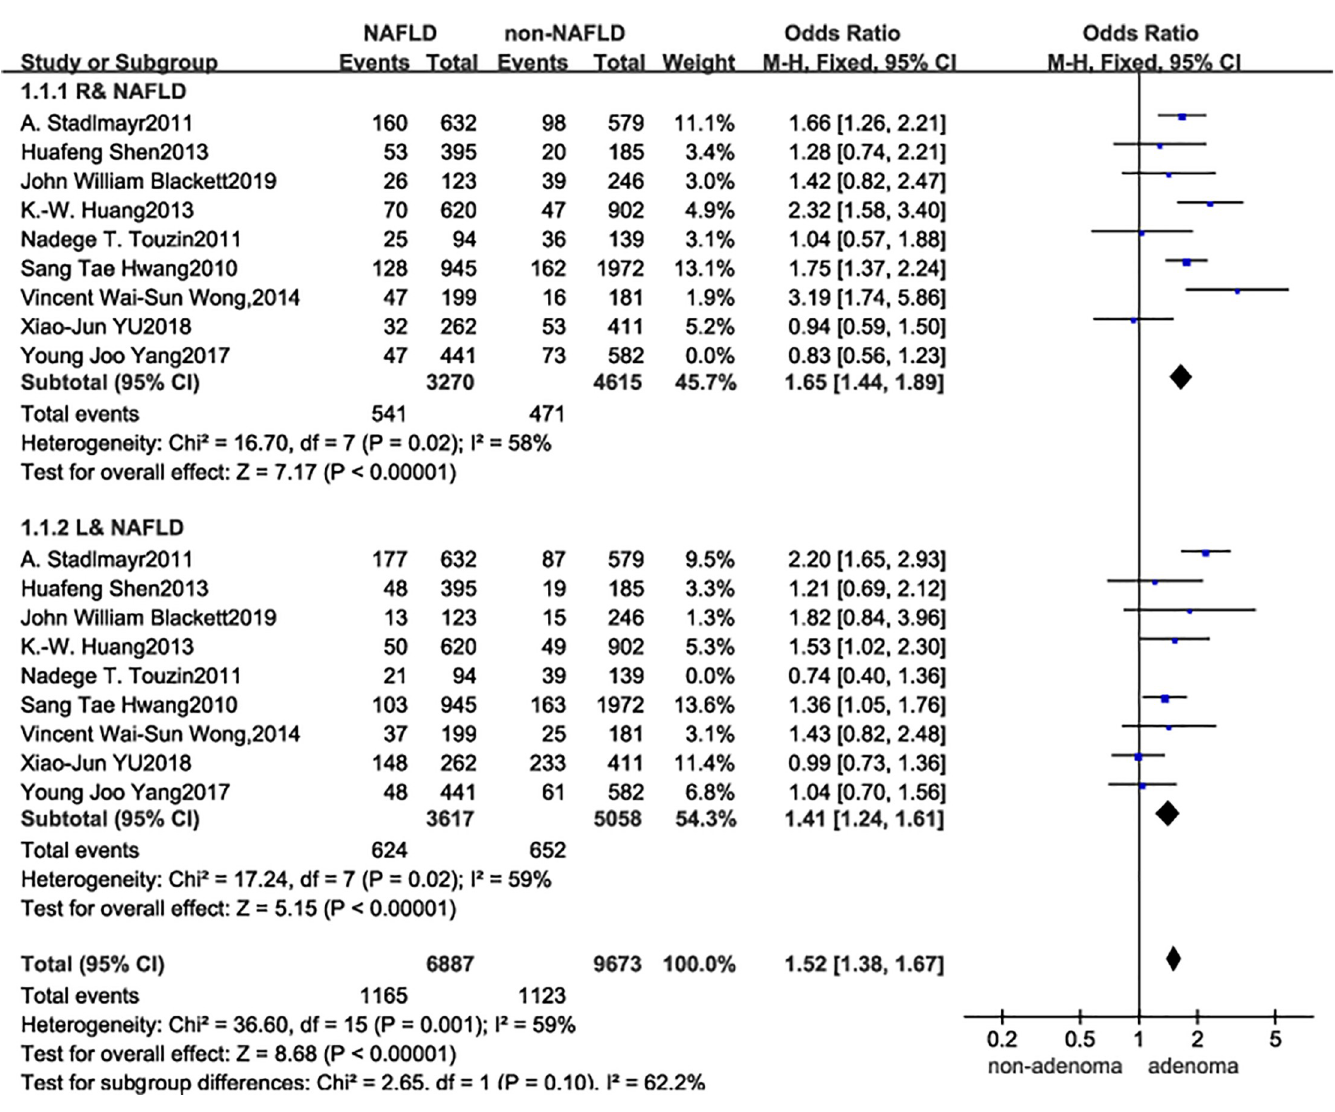
Female & Left: OR = 1.17, 95% CI 0.79–1.72, I 2 = 58%, P = 0.09). It should be noted that the number of included studies (n = 4) was relatively small, and an increased number of studies will be needed to confirm this finding. (Note: “Male&Right” means the risk correlation of the right colon tumor between male and NAFLD.“Male&Left” means the risk correlation of the left colon tumor between male and NAFLD.The following”Female&Right””Female&left”“A- sian&Right””Asian&Left””European&Right””European&Left” keep the same interpretive mode as above.)